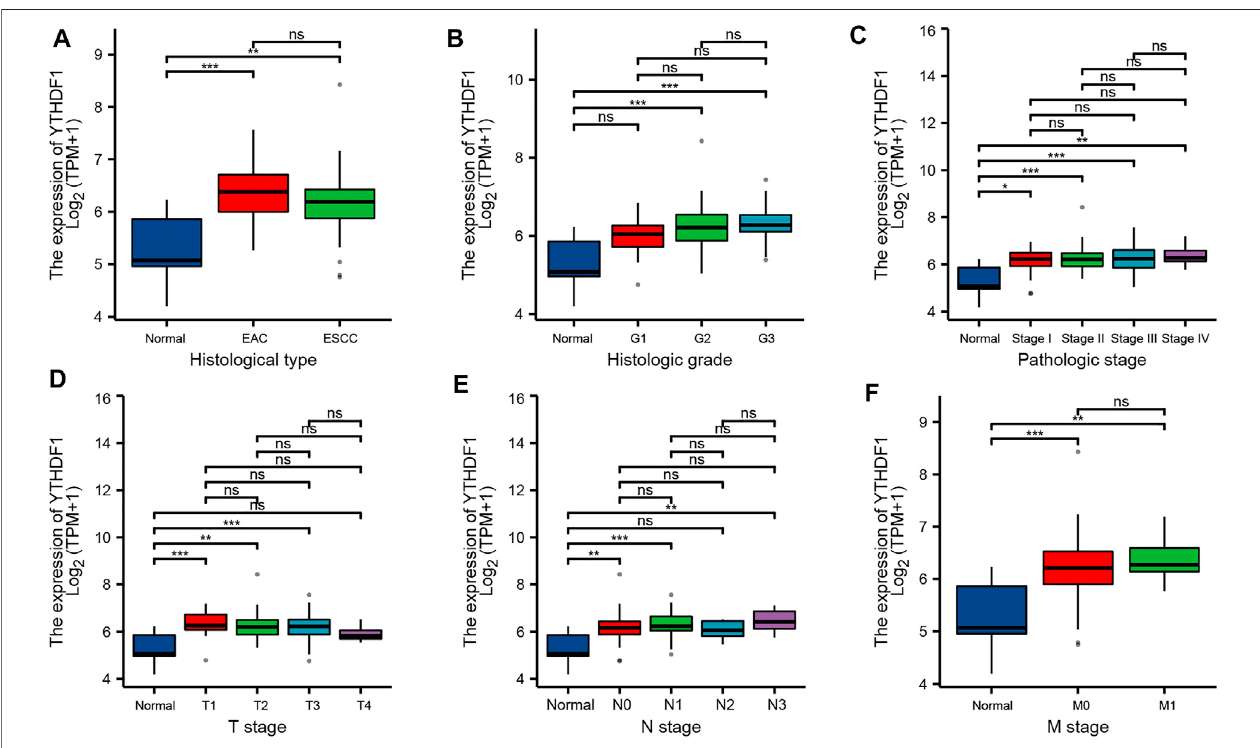
FIGURE3| RelationshipbetweenYTHDF1mRNAexpressionandclinicopathologicalparametersinesophagealcarcinoma(ESCA)patients.Relationshipbetween YTHDF1 mRNA expression level and (A) histological type, (B) histologic grade, (C) pathologic stage, (D) T stage, € N stage, and (F) M stage. * p < 0.05; ** p < 0.01; *** p < 0.001; ns, no signi fi